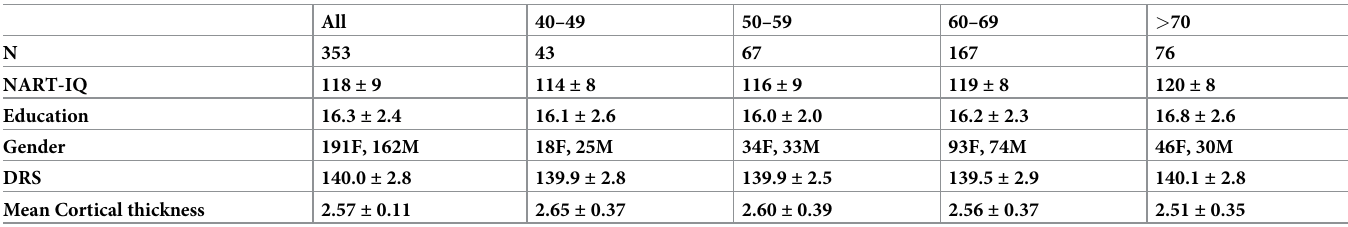
Table 1. Sample characteristics, broken down by age decade. NARTIQ = North American Reading Test for adults [18], DRS = Dementia Rating Scale [19].